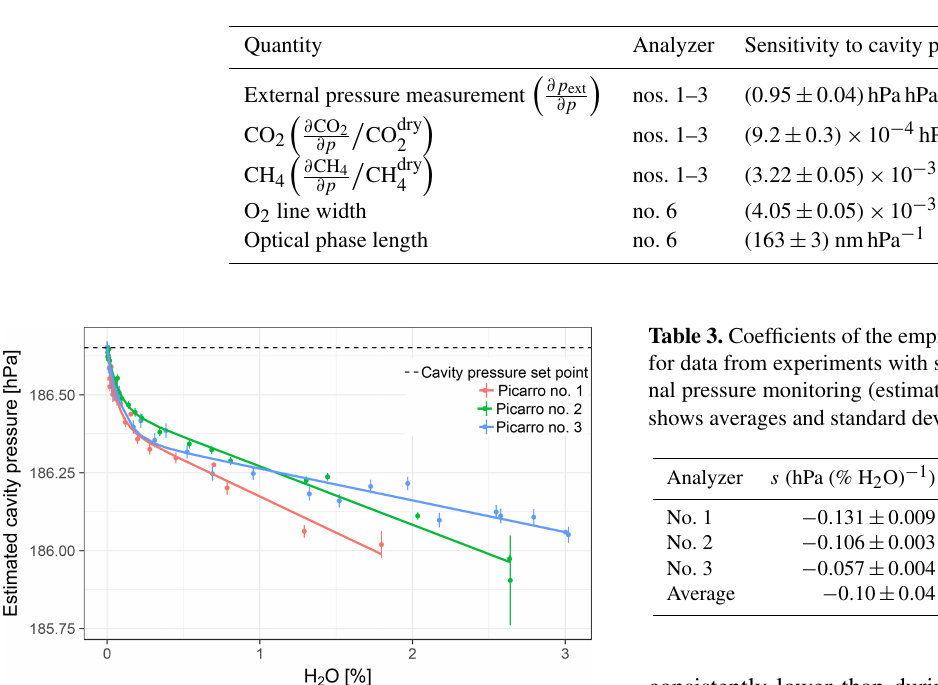
Table 2. Sensitivities of readings of Picarro GHG analyzers and independent pressure measurements to variations in internal cavity pressure p . For the quantities pertaining to GHG analyzers, averages and standard deviations of all sensitivity experiments are reported, while for the quantities pertaining to the O 2 analyzer, mean and standard error of the fit of the single experiment are given.